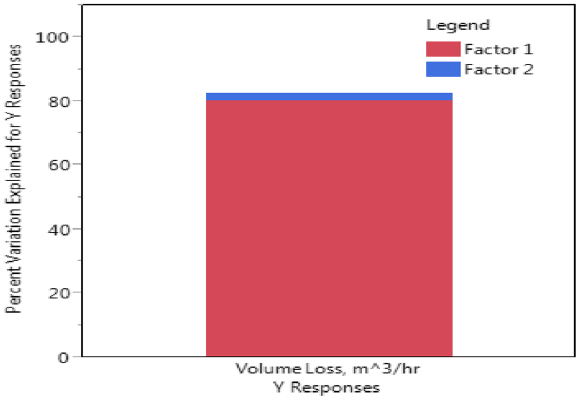
Fig. 12 Percent of variation explained by each factor for Y -variable (volume loss model)